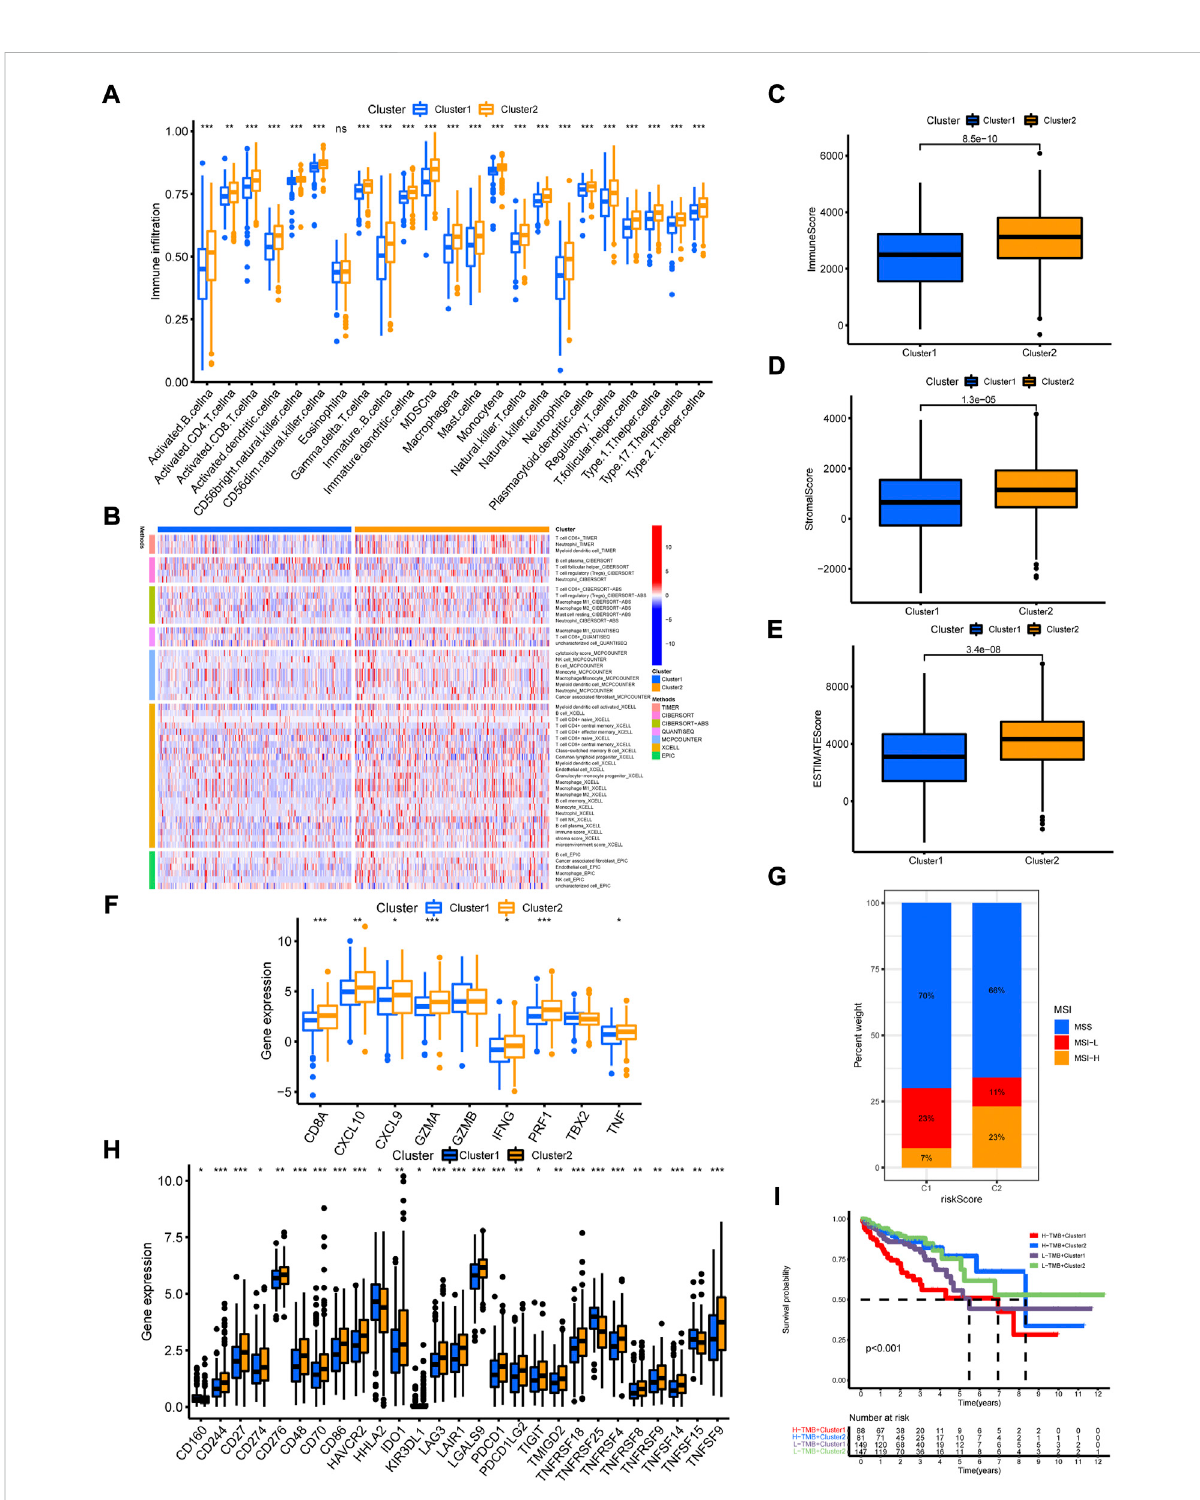
FIGURE 7 The immune cell in fi ltration characteristics of cuproptosis-related clusters. (A) The enrichment of immune cells in the two clusters by ssGSVA algorithm. (B) The immune cell bubble plot in the two clusters. (C – E) The immune score, stromal score and ESTIMATE score in the two clusters by ESTIMATE algorithm. (F) The expression of immune activated genes between the two clusters. (G) The expression of immune checkpoint genes betweenthetwoclusters. (H) ThedistributionofMSIstatusinthetwoclusters. (I) TheKaplan-Meiercurvesofoverallsurvivalindifferentgroups of TMB combination with clusters. * p < 0.05; ** p < 0.01; *** p <